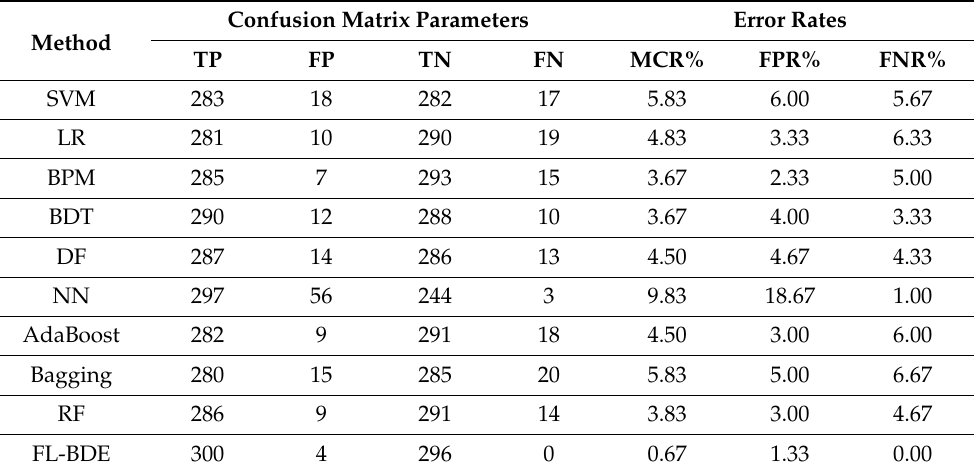
Table 4. Confusion Matrix parameters and error rates of FL-BDE, ML- and EL-based models at the split ratio of